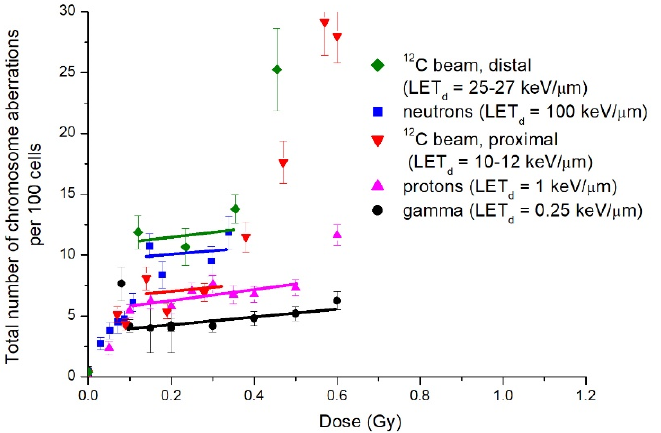
Figure 5. Total frequency of chromosome-type aberrations induced by radiations with different LET values. Legend lists radiations in the order of chromosome aberration level in the IRR response dose range increase. In parentheses: dose-averaged LET d .